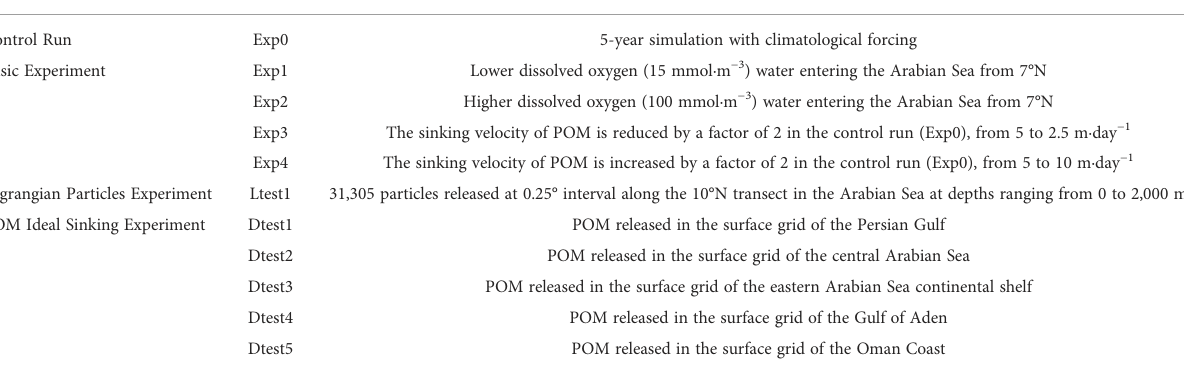
TABLE 1 Numerical experiment